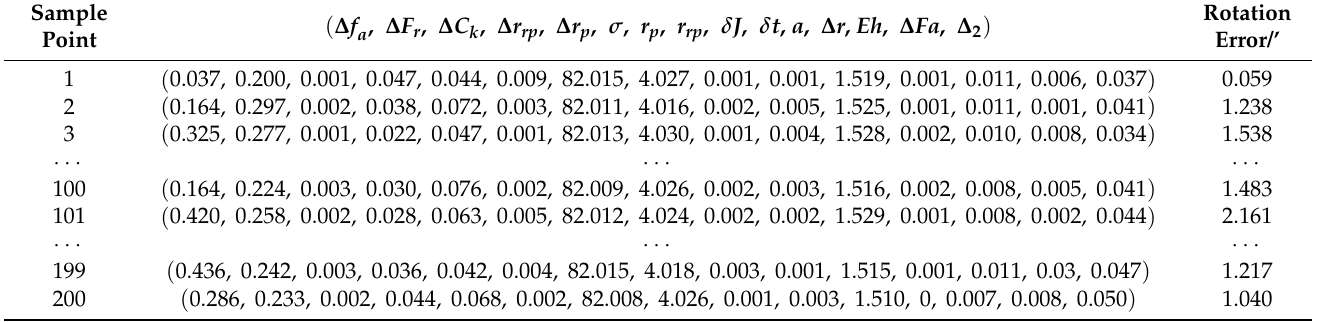
Table 3. The set for training rotation error prediction